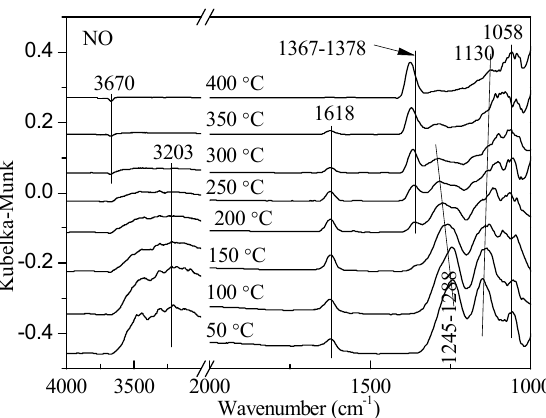
Figure 1. In situ DRIFTS (diffuse reflectance infrared Fourier transform spectroscopy) spectra of NO desorption on 1 wt. % V 2 O 5 -0.2CeO 2 /TiO 2 -ZrO 2 as a function of temperature after the catalyst was exposed to a flow of 800 ppm NO for 60 min at 25 °C.